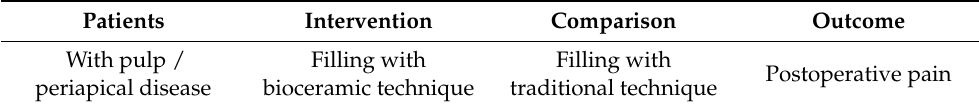
Figure 1. The preferred reporting items for systematic reviews and meta-analysis flow diagram of the search results. Table 1. Cochrane PICO